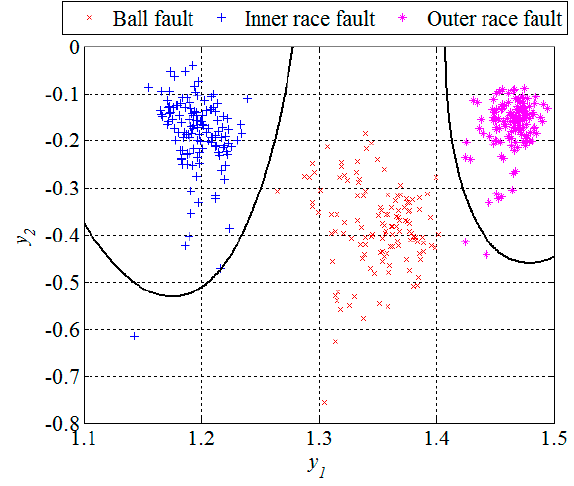
Figure 12. Dimension reduction and classification for the fault diagnosis, segments of the design set.